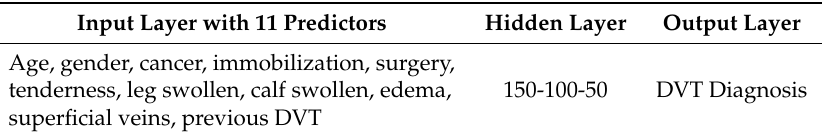
Table 5. Proposed prediction model for DVT